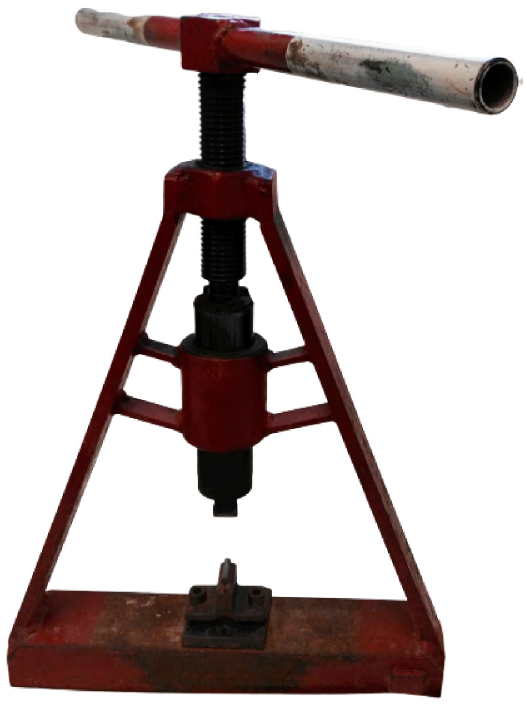
Figure 2. Manual press designed to split sedimentary rocks using protective eye goggles.